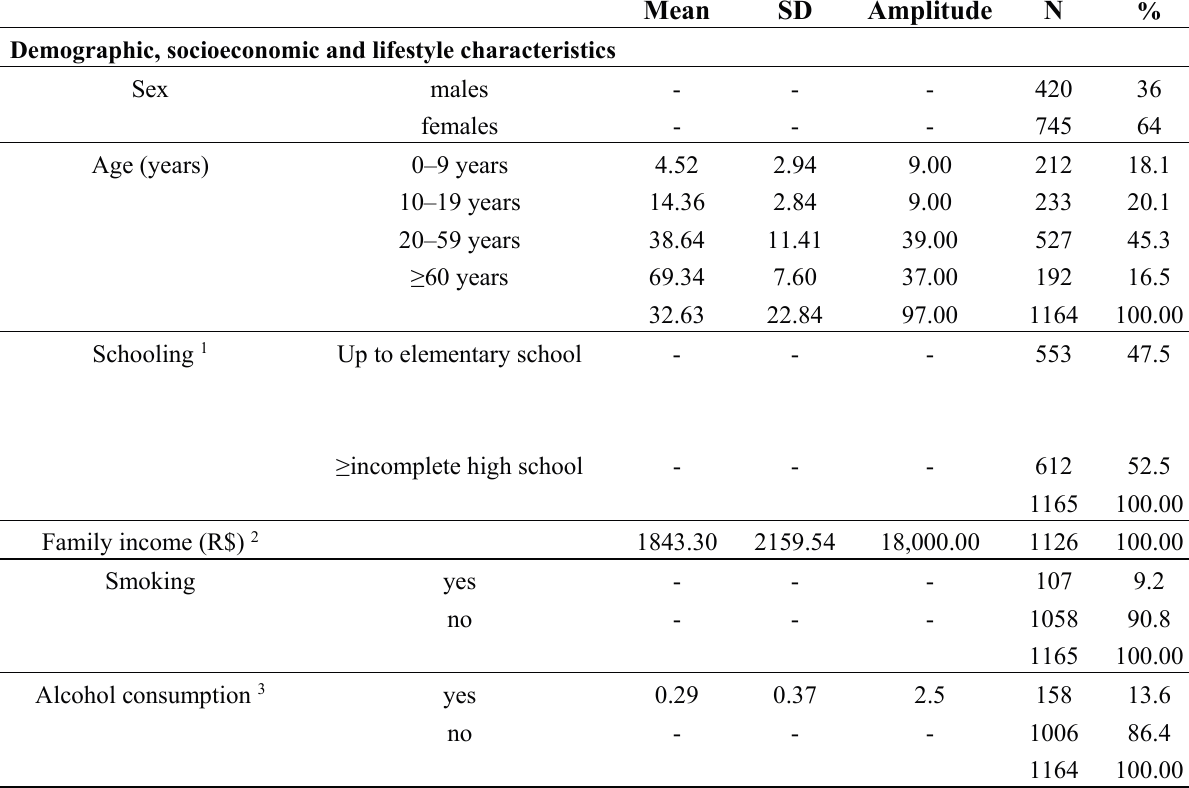
Table 1. General characteristics of individuals from I DISANDNT/JP, for the municipality of northeastern Brazil